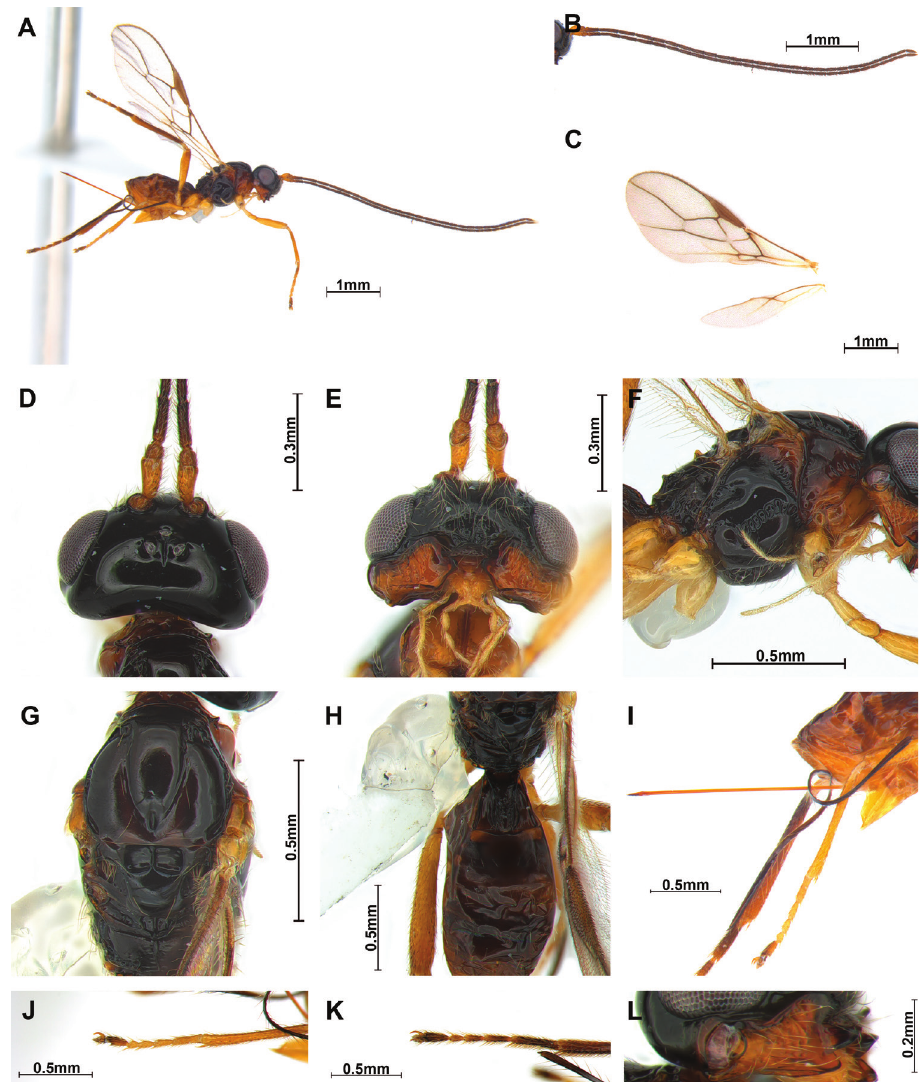
Figure 5. Phaenocarpa masha Belokobylskij, 1998, ♀ A body B antennae C wings D head, dorsal E head, anterior F mesosoma, lateral G mesosoma, dorsal H propodeum and T1 to T3, dorsal I meta- soma, ovipositor and its sheaths, lateral J tarsus, lateral K tarsus, dorsal L mandible, lateral. metapleuron. Propodeum (Fig. 5H) 0.7 times longer than width, more extensively rugose medially; lateral view of propodeum not bent; precoxal sulcus (Fig. 5F) com- pleted with 11 crenulae; scutellum with setae partially. Fore wing (Fig. 5C) 2.5 times as long as wide; pterostigma long and narrow, 4.2 times longer than wide; vein r of fore wing 3.0 times longer than wide; vein r-m not sclerotized; vein 2-SR:vein r:vein 3-SR = 10:2:14; first subdiscal cell of fore wing ca 0.7 times longer than wide; second submarginal cell